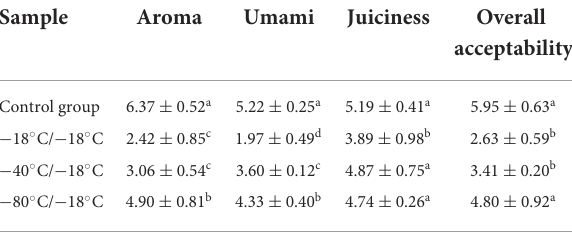
TABLE 8 Sensory evaluation of HGM with different freezing rates. Sample